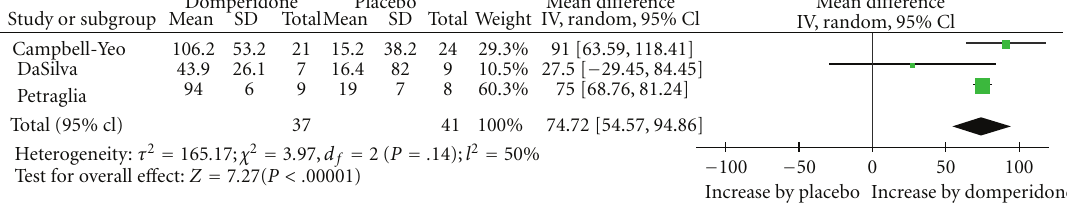
Figure 2: Percent change in milk volume with domperidone